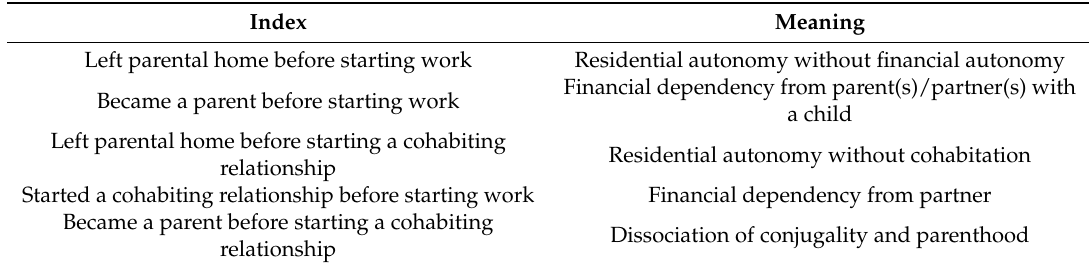
Table 1. Indexes of change to normative transitional order *.